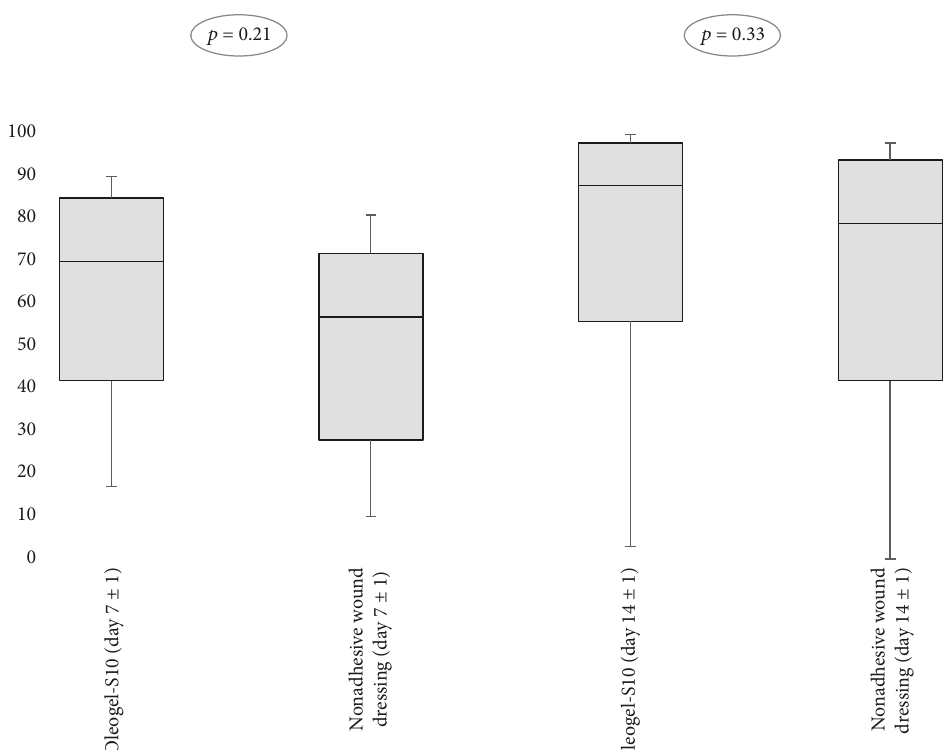
Figure 4: Percentage of wound area with a newly formed epithelial layer on day 7 ± 1 and day 14 ± 1 .